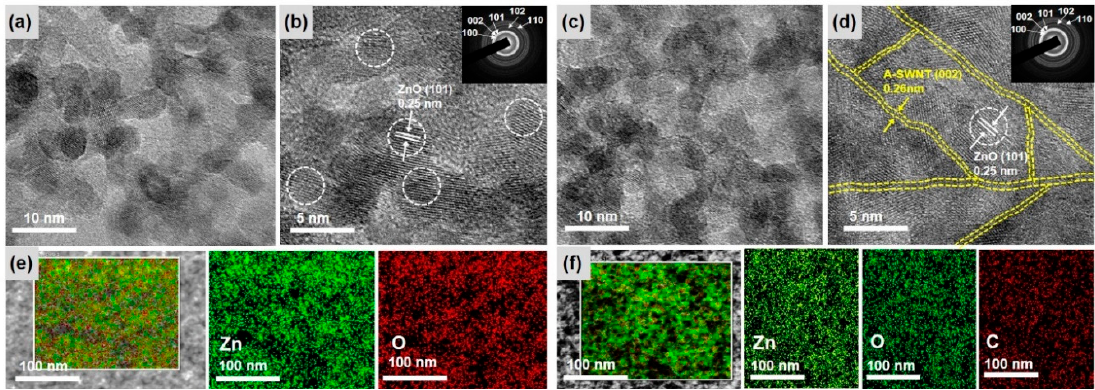
Figure 2. Bright-field TEM images of ( a ) ZnO NPs and ( c ) ZnO@SWNT; HRTEM images of ( b ) ZnO NPs and ( d ) ZnO@SWNT (SAED pattern are shown in the insets in Figure 2b,d); and STEM images with the corresponding EDS mapping images of ( e ) ZnO NPs structure and ( f ) ZnO@SWNT.